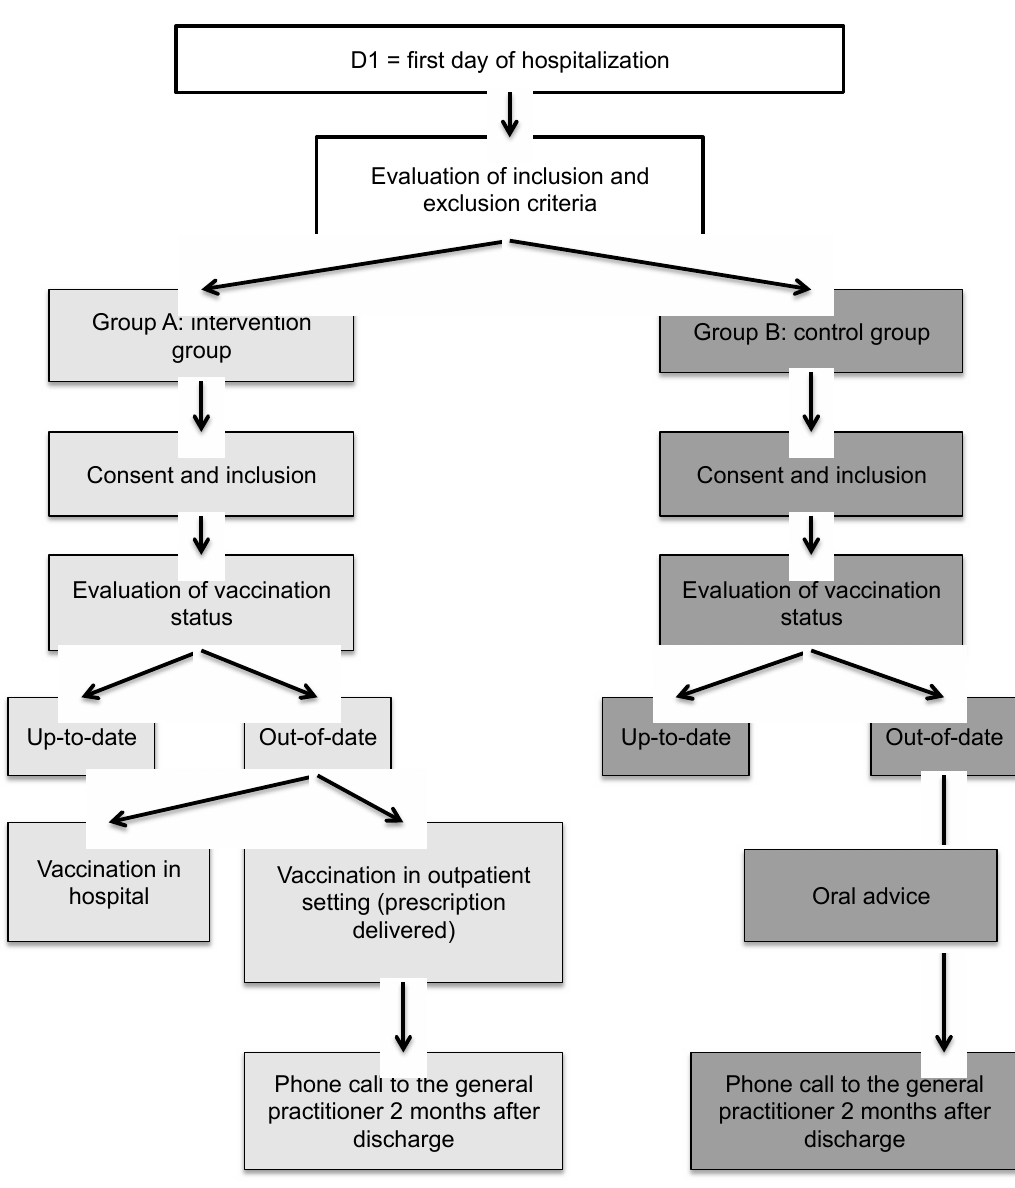
Figure 1. Study flow chart.